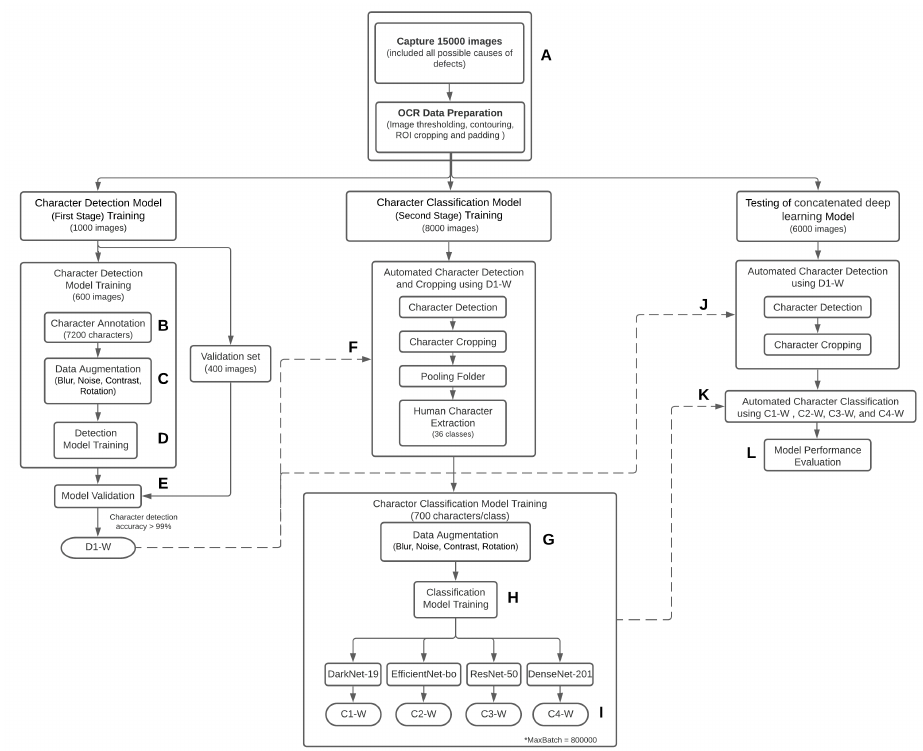
Figure 4. Schematic diagram of the concatenated deep learning model.